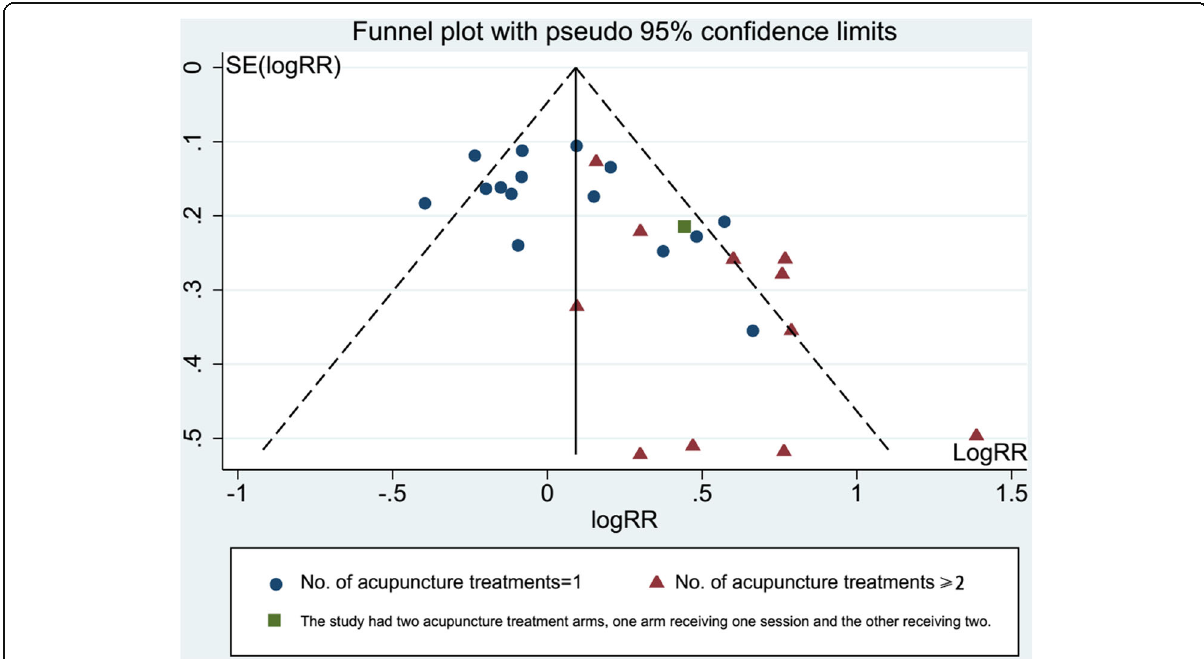
Fig. 5 The funnel plot for the 27 eligible studies (Begg ’ s and Egger ’ s test, p = 0.006). The studies are separated into two groups by No. of acupuncture treatments either one or more than